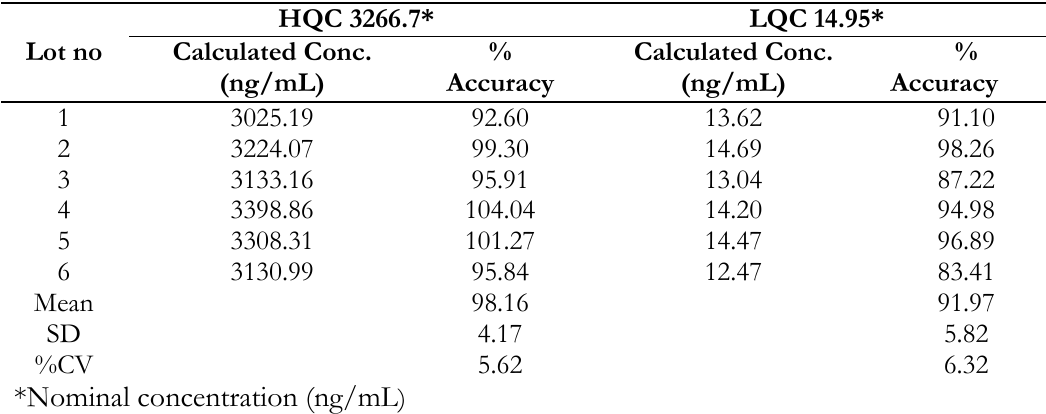
Table III. Matrix Effect Data of Omeprazole in Six Different Lots of Human Plasma at HQC and LQC